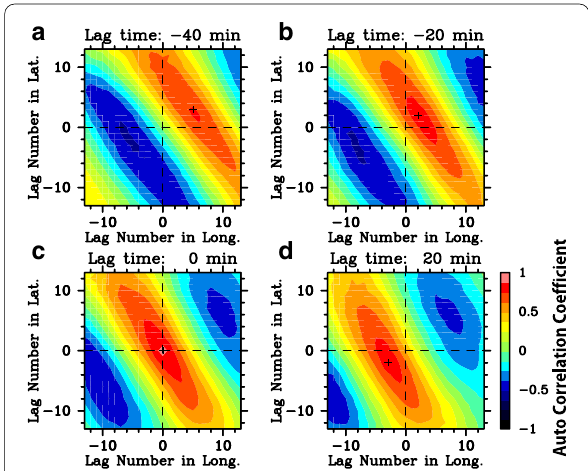
Fig. 2 Two-dimensional auto-correlation functions (ACFs) as a function of lag numbers in longitude and latitude at different lag time of a 40, b 20, c 0, and d 20 min, obtained from the − − detrended TEC within the area of 133.0°–137.0° E and 33.0°–37.0° N (shown in Fig. 1) and during a period of 2 h between 14:00 and 16:00 UT on 8 June 2019. A maximum ACF for each lag time is shown by a symbol ‘ ’ in the figure +